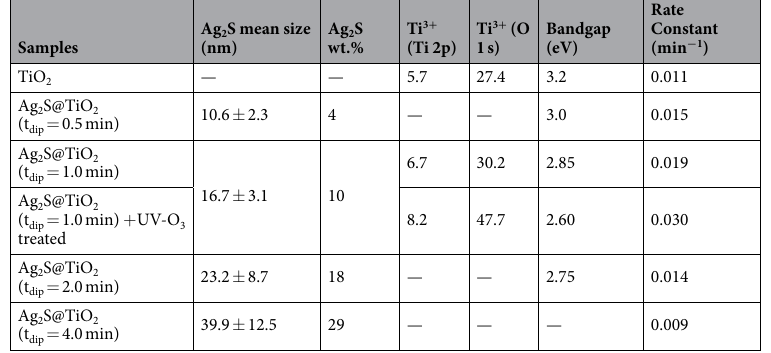
Table 1. Material characteristics and photodegradation rate constants for all the